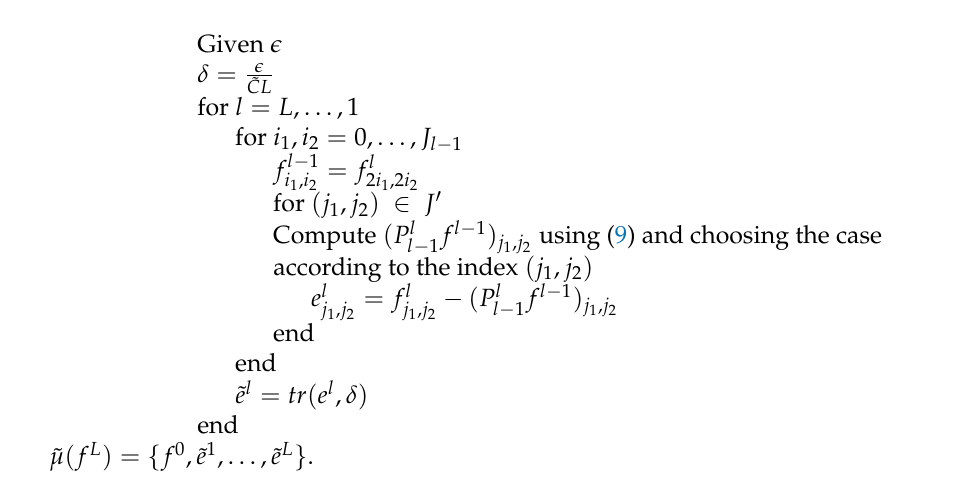
Algorithm 3: ˜ µ ( f L ) = ˜ M f L (Alternative Coding to monitor the accumulated